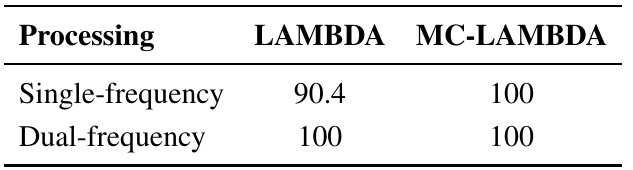
Table 2. Empirical instantaneous ambiguity resolution success rate (%) for attitude determination using static data (0.6-m baseline).